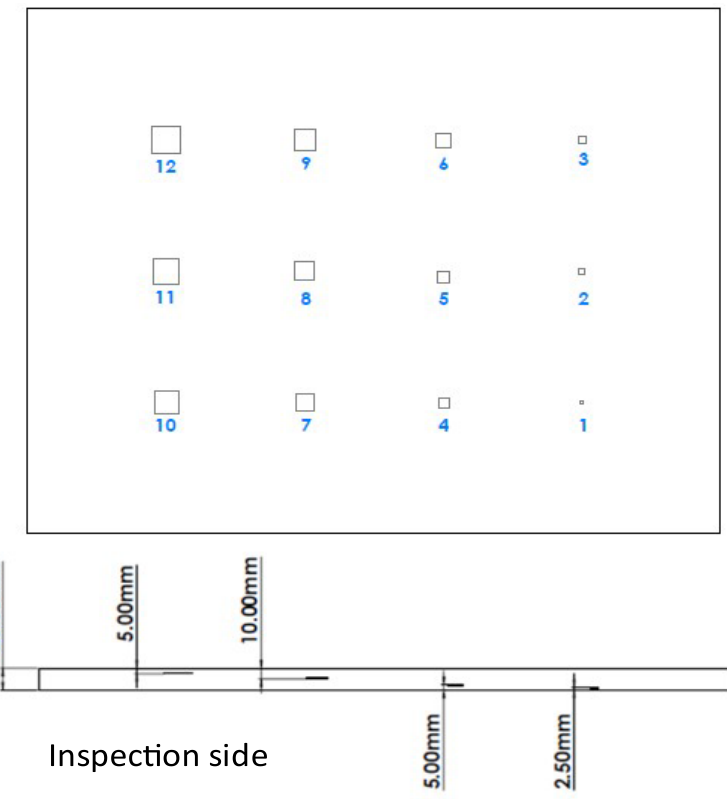
Figure 2. Schematic of the monolithic plate sample. Table 3. Dimensions of the artificial Teflon defects for the monolithic sample.